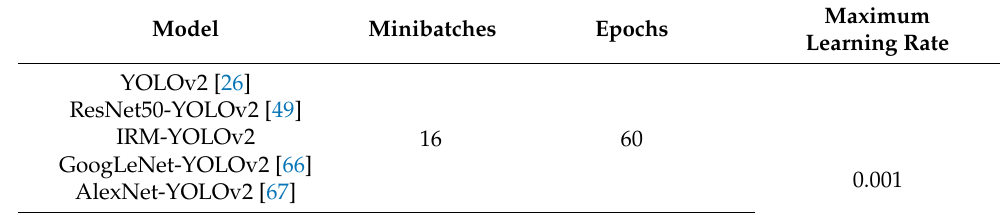
Table 1. Configuration of the proposed detector model.